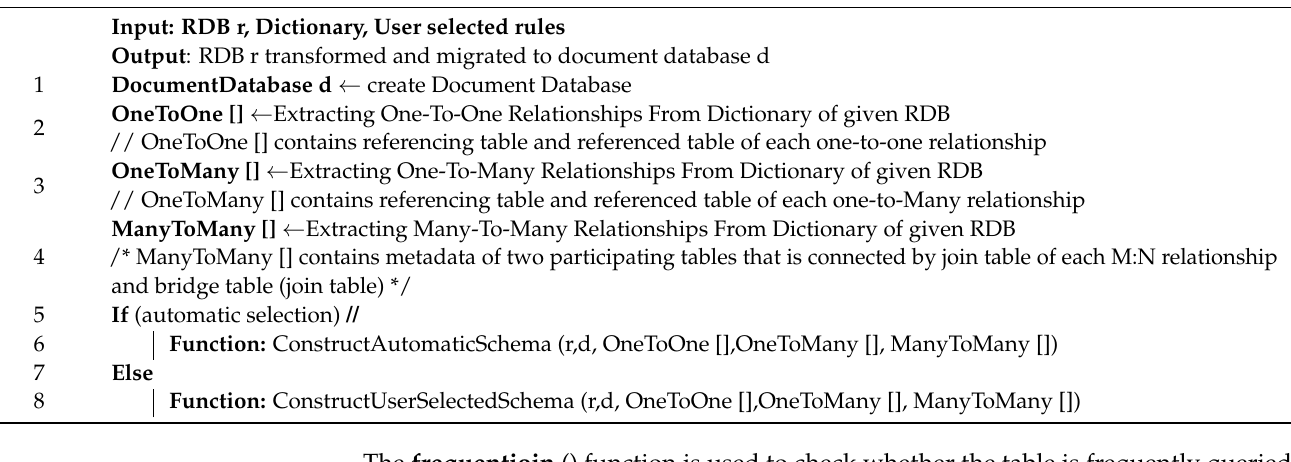
Algorithm 1: TRANSFORMATION AND MIGRATION FROM AN RDB TO A DOCUMENT